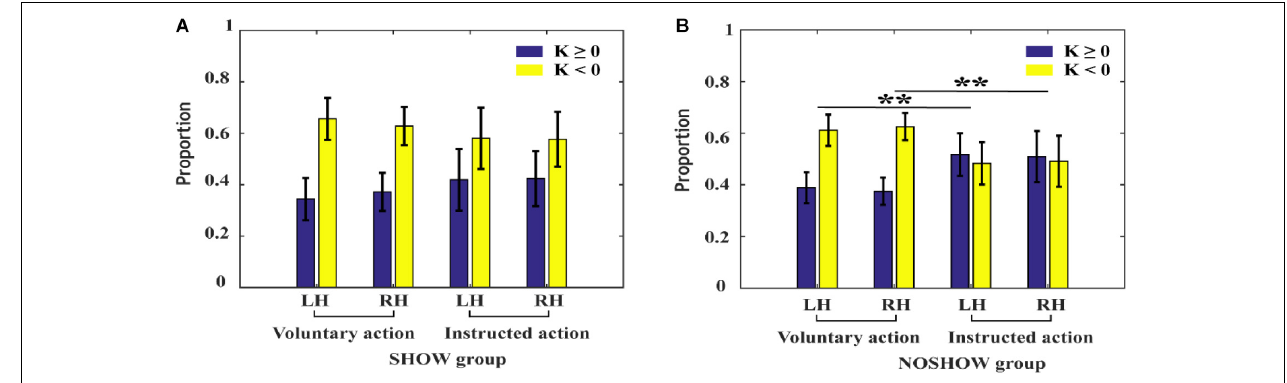
FIGURE 6 | The proportion of negative and positive shifts during voluntary/instructed actions. (A) SHOW group, (B) NOSHOW group (** p <